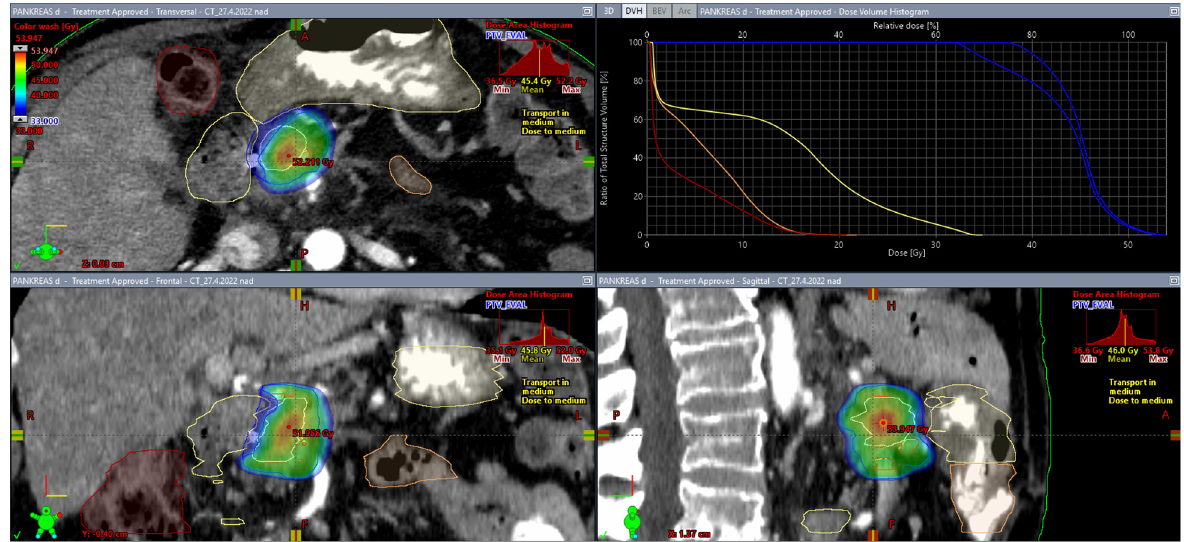
Figure 3. Dose coverage. PTV 38.03 cc (blue; near-maximum dose of 51.26 Gy; mean dose of 43.42 Gy; near-minimum dose of 32.9 Gy), PTV_EVAL 32.01 cc (blue; near-maximum dose of 51.49 Gy; mean dose of 45.01 Gy; near-minimum dose of 38.73 Gy), duodenum (yellow; maximum dose of 32.55 Gy), stomach (yellow; maximum dose of 21.50 Gy), small bowel (orange; maximum dose of 15.11 Gy), and large bowel (brown; maximum dose of 14.88 Gy). The compromise in dose coverage caused by the vicinity of the duodenum and stomach is displayed. The corresponding DVH is plotted in the upper-right corner. Near-maximum and near-minimum doses correspond to ICRU report 83 recommendations.